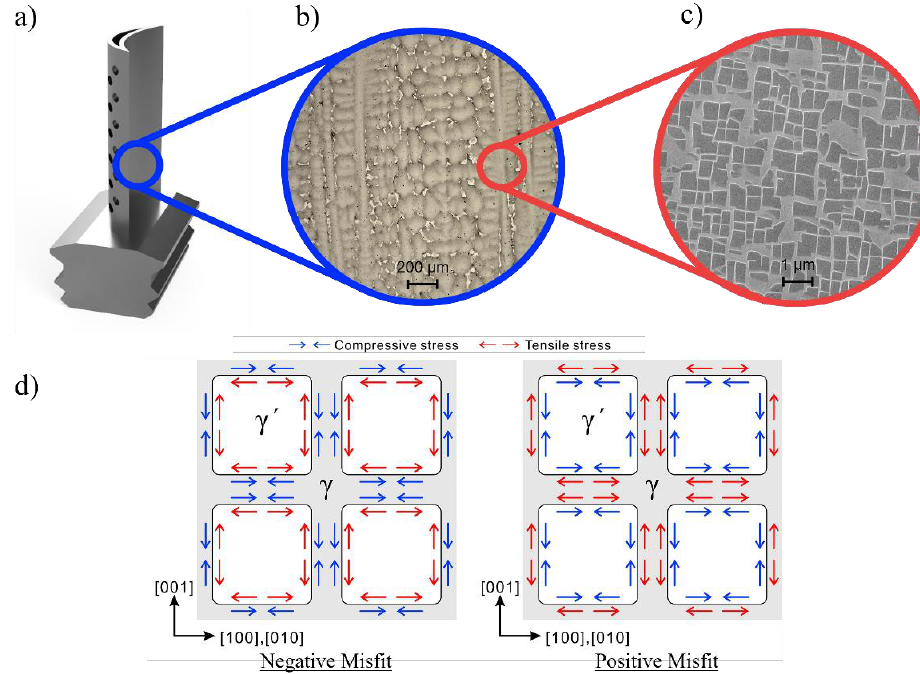
Figure 2. ( a ) A typical single crystal Ni-based superalloy compressor turbine blade, along with ( b ) a corresponding optical microscope image showing the dendritic microstructure of CMSX-4. ( c ) An SEM micrograph of the microstructure within the dendrite core of CMSX-4 showing the cuboidal γ/γ’ microstructure. ( d ) Schematic of the negative misfit stress distribution (compressive stresses in the γ channels and tensile stresses in the γ’ precipitates) and positive misfit stress distribution (tensile stresses in the γ channels and compressive stresses in the γ’ precipitates). Reprinted from [32] with permission from Elsevier.